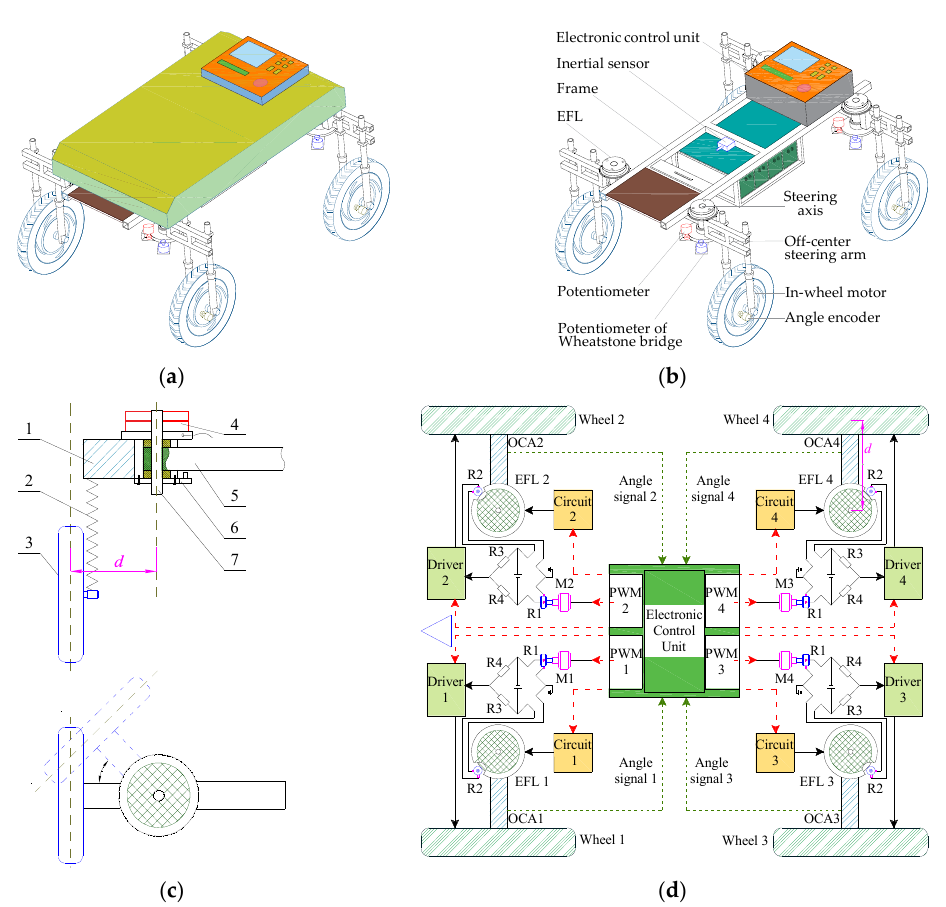
Figure 2. Diagram of system structure for the robot chassis: ( a ) Overall design; ( b ) Chassis model; ( c ) Simplified model of off-center steering mechanism; ( d ) Electrical system diagram. 1. OCA; 2. Suspension; 3. In-wheel motor; 4. EFL; 5. The chassis frame; 6. Precision multi-turn potentiometer (R2 in ( b ); 7. Off-center axis. Note: M1 to M4 denotes the stepper motor; R1, R3, and R4 represent the potentiometer of the bridge circuit; R2 represent precision multi-turn potentiometer.